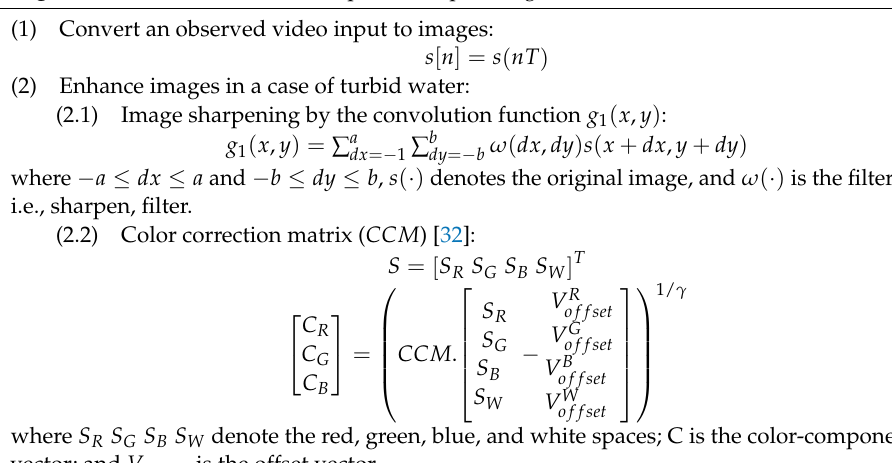
Algorithm 1. Overview of the Proposed Tilapia Weight-Estimation Evaluation